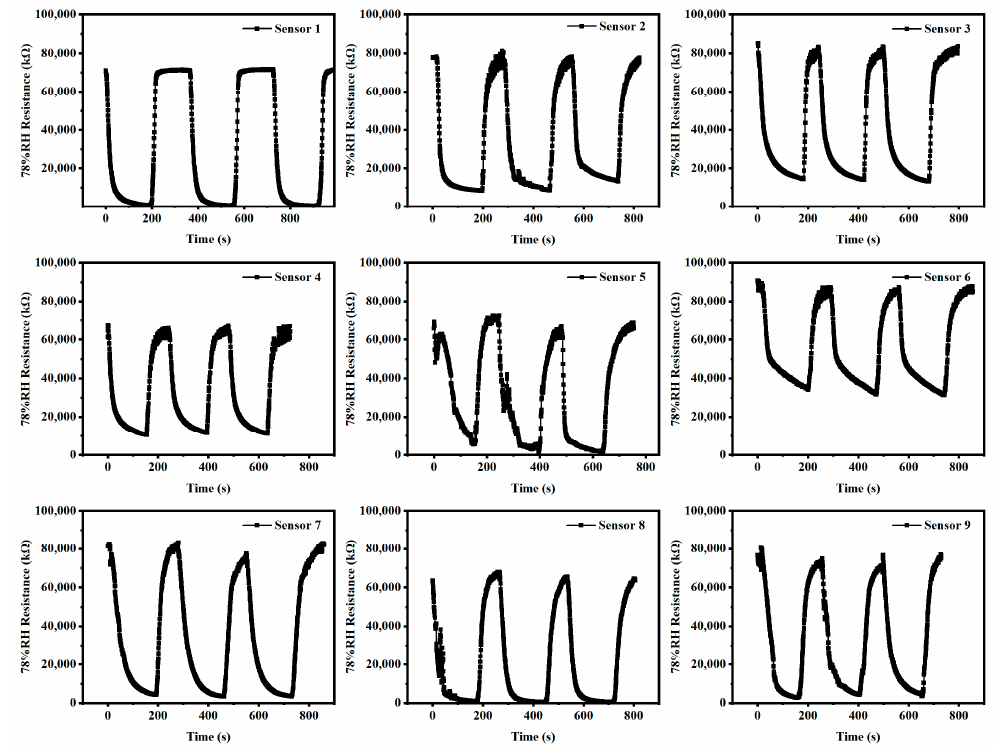
Figure 8. Resistance variation of nine humidity sensors with different electrodes in 78% RH.